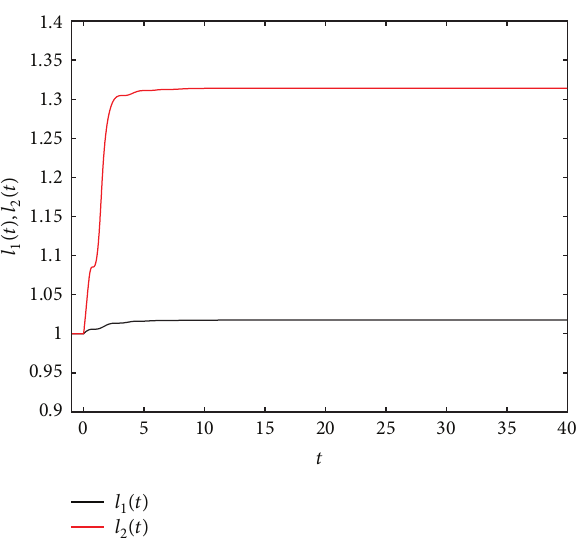
Figure 3: Trajectories of control parameters 𝑙 1 (𝑡) and 𝑙 2 (𝑡) .